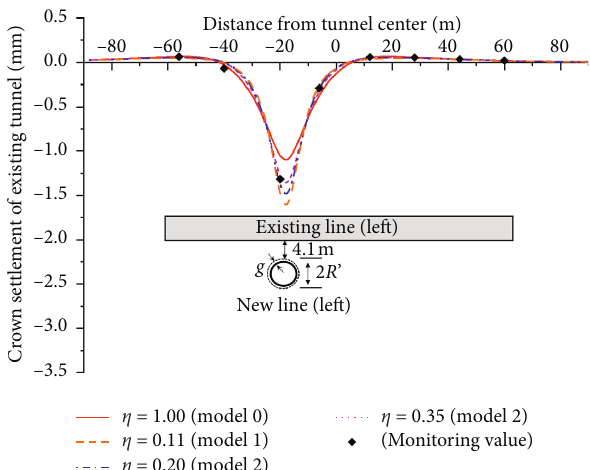
Figure 7: The settlement curves of the existing tunnel after the completion of new metro line (left). After the completion of the twin line, the convergence ellipse diagrams of the existing tunnel lining using different models are plotted in Figure 10. The red dotted line rep- resents the initial lining ring of the existing shield tunnel, while the other lines represent the fitted convergence el- lipses. Since the existing tunnel (left line) is undercrossed from left to right side by the newly built shield tunnel (new metro line), each convergence ellipse tends to elongate